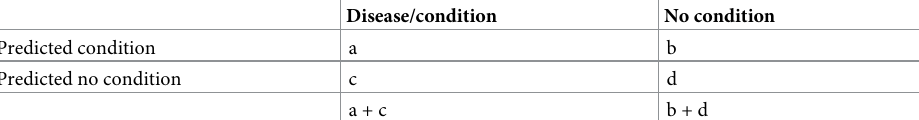
Table 8. General shape of the confusion matrix.